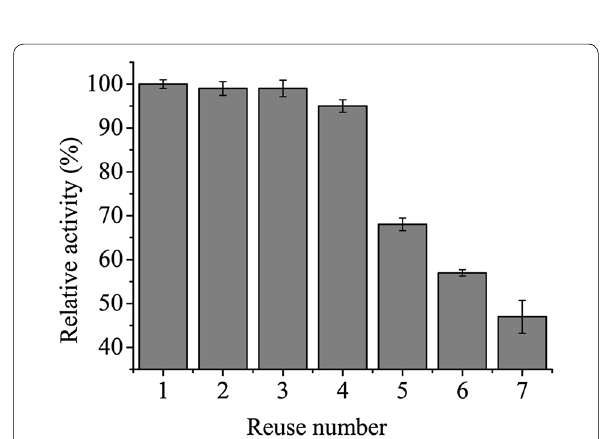
Fig. 5 The relative nitrilase activity of BNASS after multiple assembly– disassembly cycles was expressed as a percentage of the maximum activity. The determination of nitrilase activity was performed at 30 °C for 30 min with 10 µM FMN under 470-nm blue light illumination. Error bars represent the standard error of three